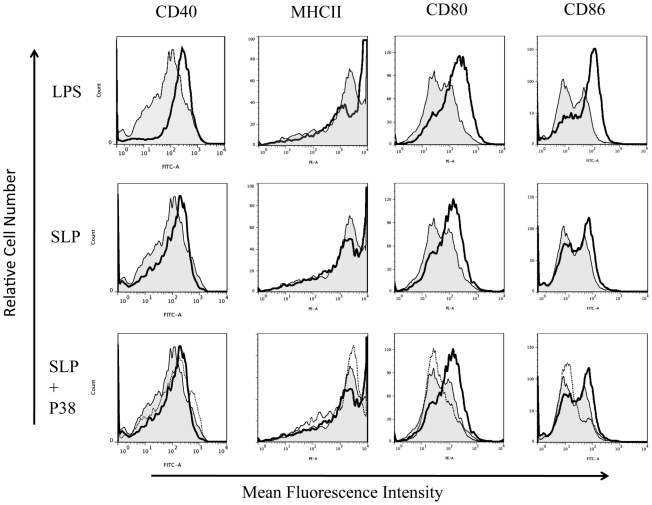
SLP-induced DC maturation is dependent on p38.DCs isolated from Balb/C mice were incubated with either LPS (100 ng/mL), SLPs (20 µg/mL) or SLPs plus the p38 inhibitor S8308 (20 µg/mL) S for 24 h. Cells were washed and stained with antibodies specific for CD40, CD80, CD86, and MHCII, or with isotype matched controls. Results of immunofluorescence analysis are shown for control DCs (filled histogram) and DCs treated with either LPS or SLPs (thin black line) in the rows one and two. In row three, control DCs (filled histogram) are represented along with SLP (dark black line) and SLPs plus S8308 (thin black line).